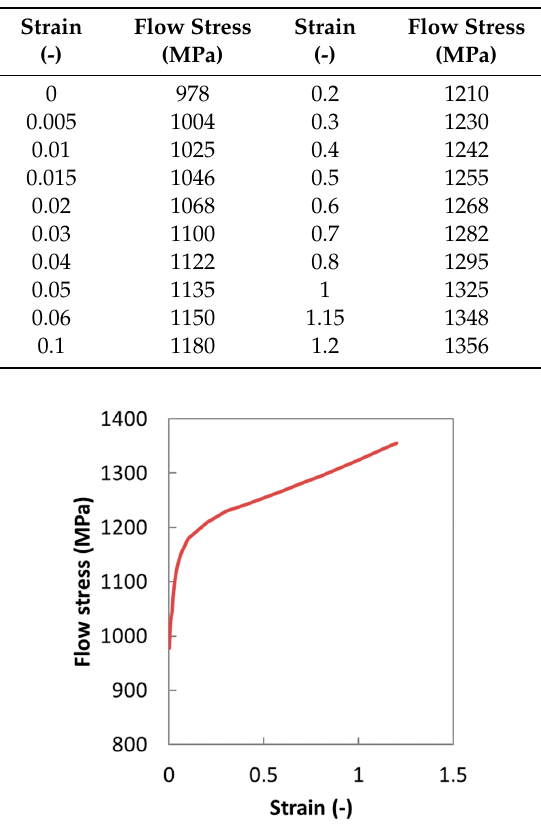
Figure 15. Flow stress plot.